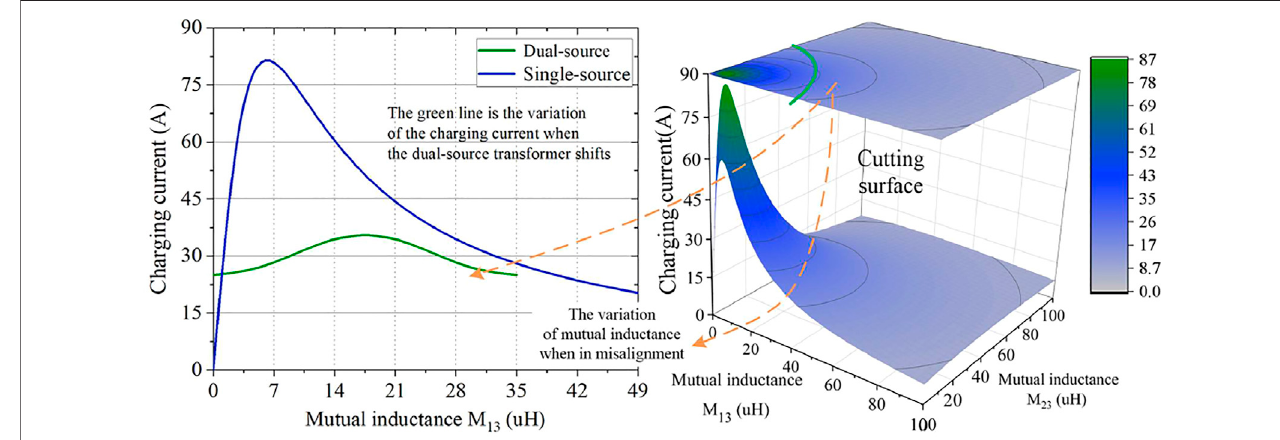
FIGURE 5 | Variation of the charging current versus mutual inductance.